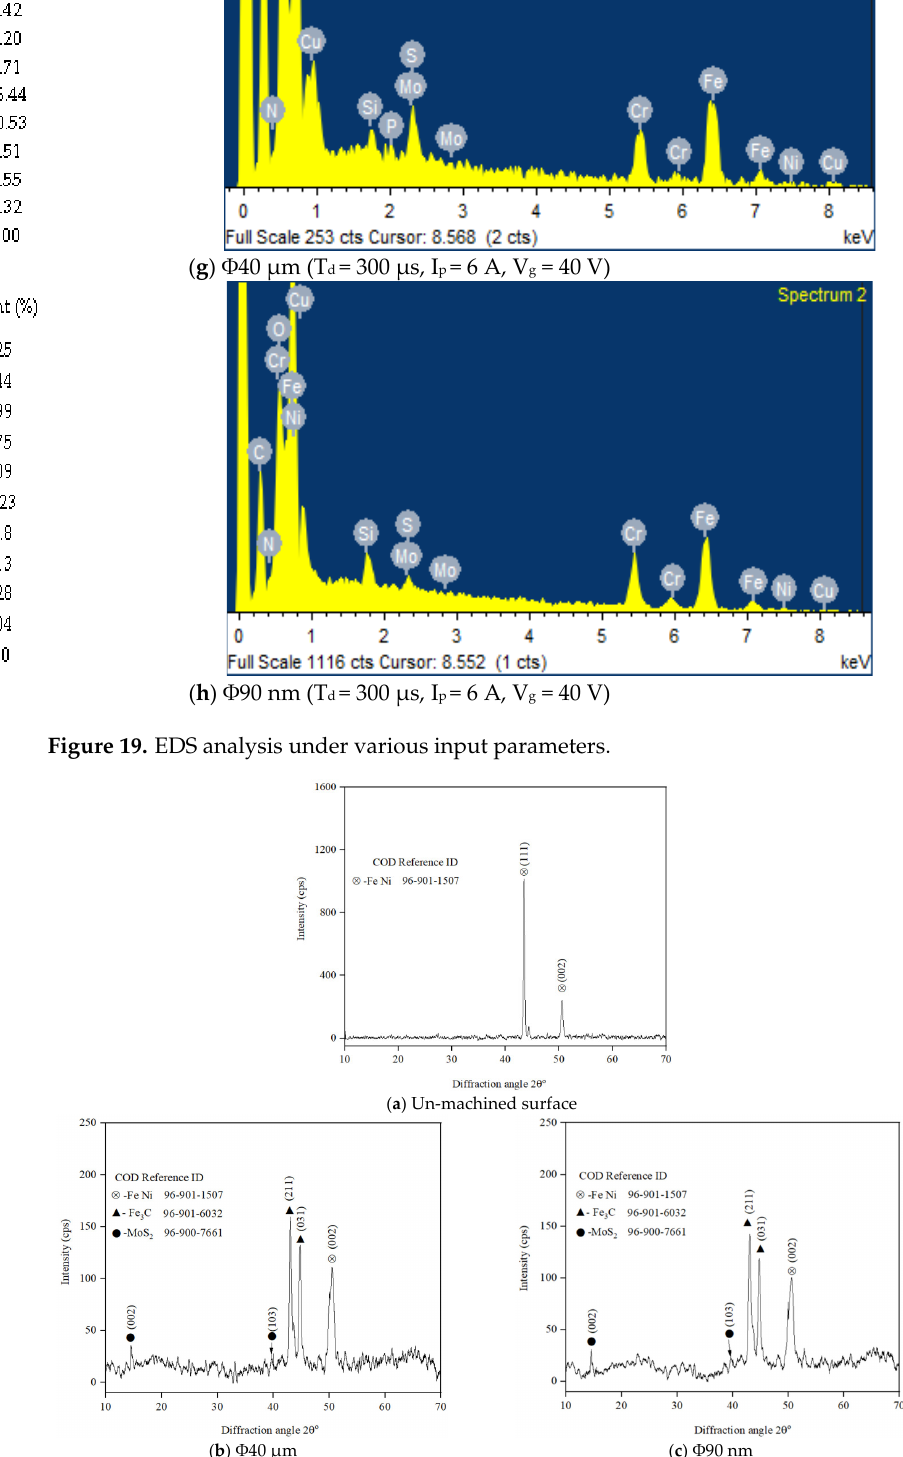
Figure 20. XRD pattern of workpiece